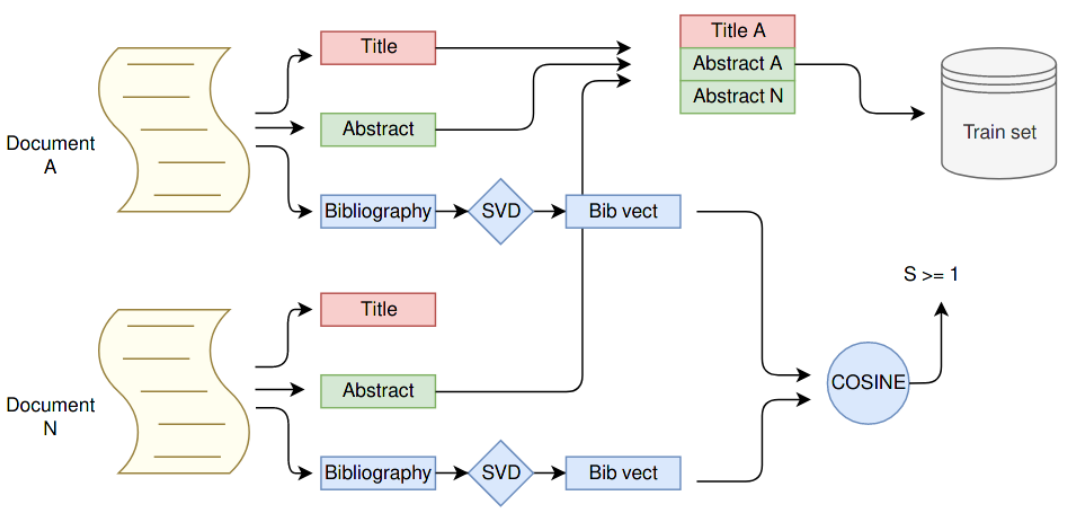
Figure 1. The picture shows how the training set is created. It turns the bibliography of two papers into vectors and then checks their cosine distance. If it is higher or equal to 1, it uses the N document as a negative one for paper A. It creates the training sample by using the title and the abstract from A and only the abstract from